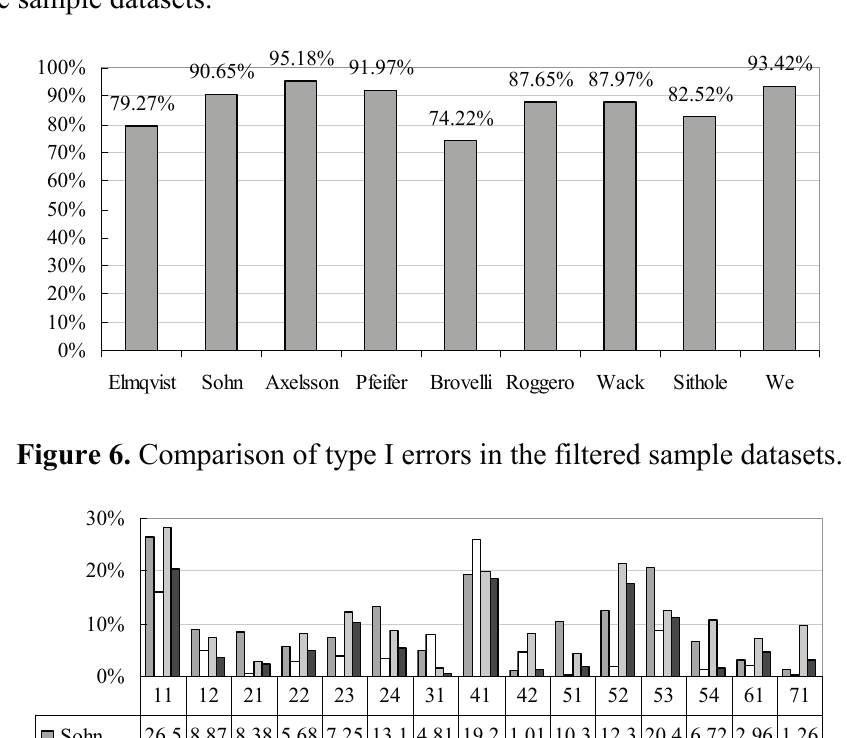
Figure 5. Comparison of the average overall accuracy of the different filtering algorithms used in the sample datasets.